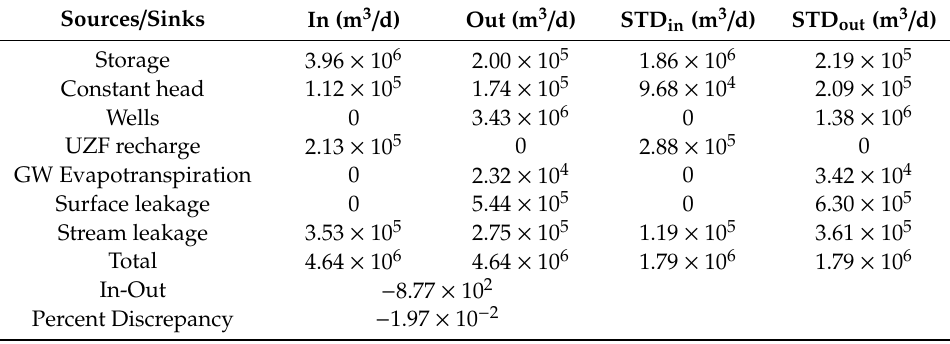
Table 2. The statistics of the groundwater budgets that were obtained from the MODFLOW in the GSFLOW